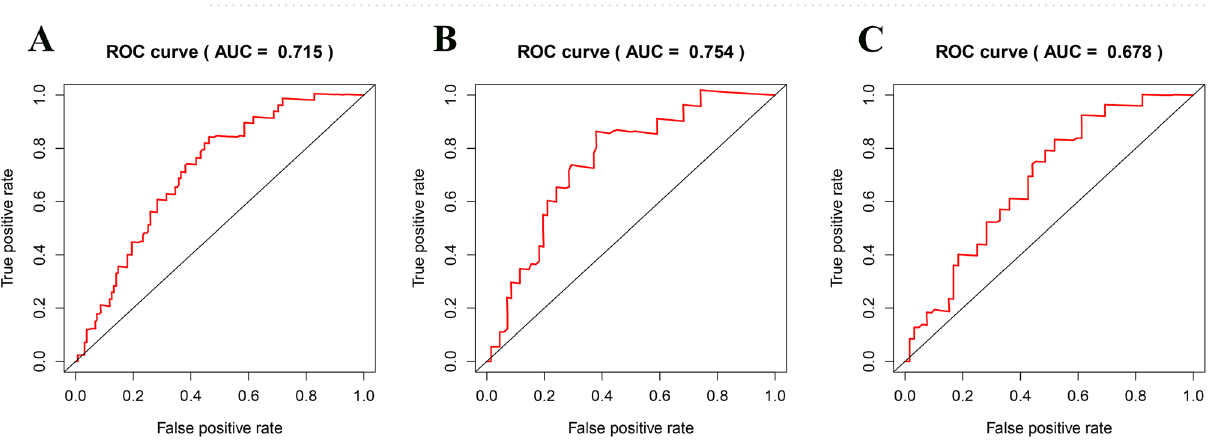
Figure 5. ROC analysis based on time for the 7-immune-related prognostic miRNA signature in PC. ( A ) ROC analysis in the whole set; ( B ) testing set; ( C ) the training set.